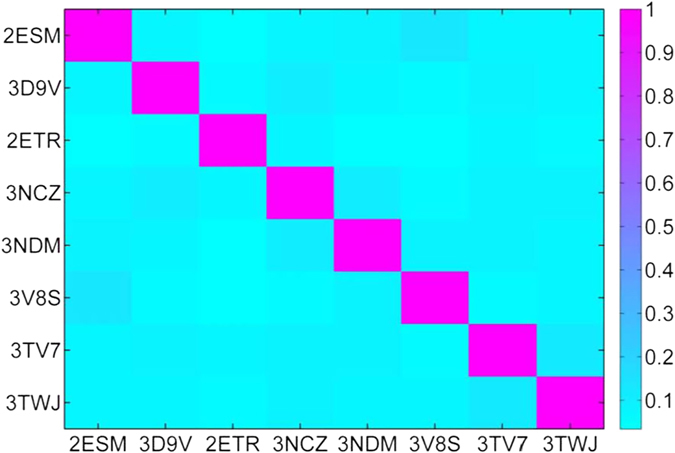
The similarity scores of Assemblies for the top 500 molecules ranked by the Glide docking scores based on eight crystal structures of ROCK1-ligand complexes.